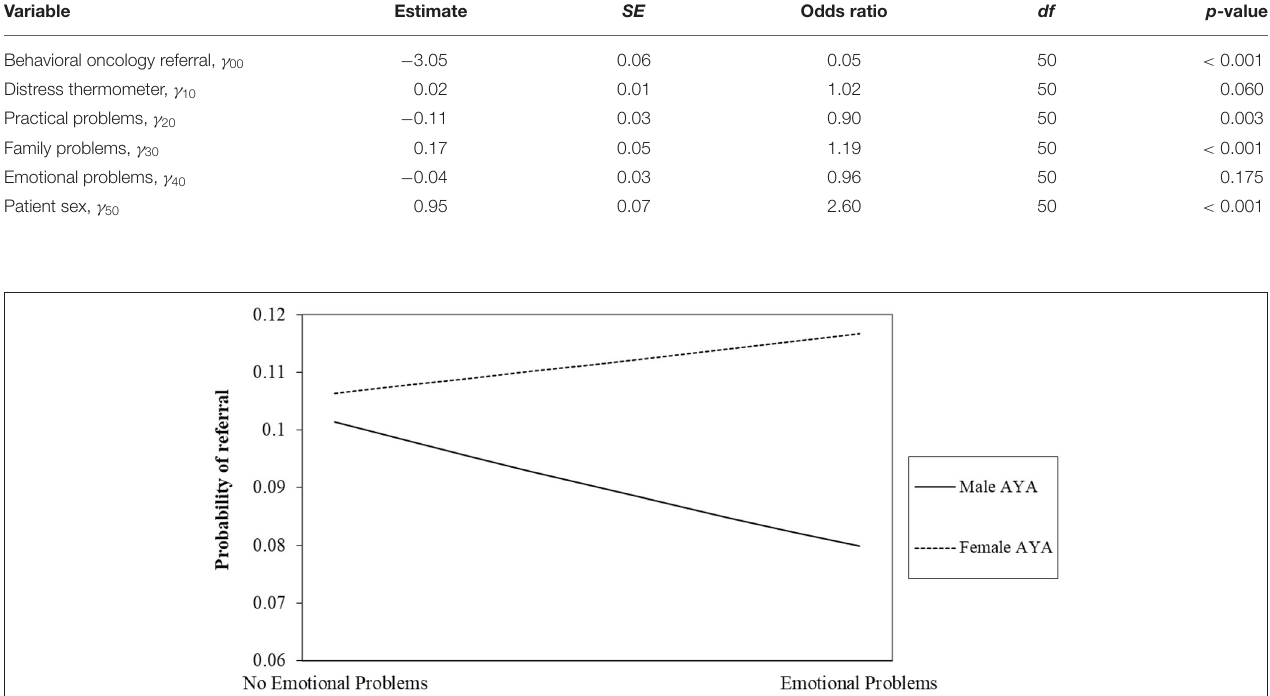
FIGURE 1 | Interaction between emotional problems and sex on odds of referral to behavioral